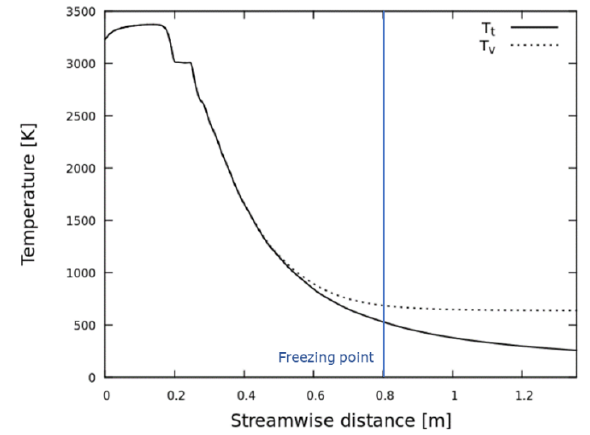
Figure 3. Distributions of temperature along the center line of the nozzle flow.